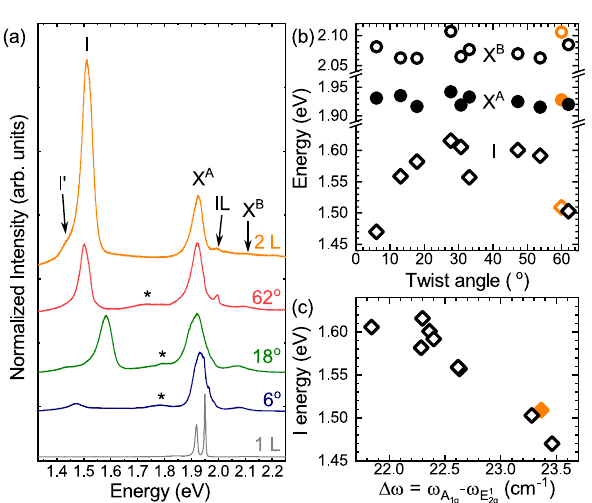
Figure 3. ( a ) Normalized low-temperature ( T = 5 K) photoluminescence spectra of thin MoS 2 layers: monolayer (1 L), bilayer (2 L) and selected homobilayers with twist angles of 6 ◦ , 18 ◦ and 62 ◦ measured under excitation of 2.41 eV laser light. The spectra are normalized to the intensity of the X A emission. ( b ) The emission energy of the direct (X A and X B ) and indirect (I) transitions as a function of twist angle ( θ ) for all the studied twisted homobilayers. The full and open black circles represent correspondingly the X A and X B , while the I emissions are indicated by the open black diamonds. ( c ) The evolution of the indirect emission energy, i.e. I, − ω versus the energy separation between the A 1g and E 1 2g peaks, i.e. �ω = ω A E 1 2g . The corresponding 1g emission energies for the 2 L are also indicated with solid orange